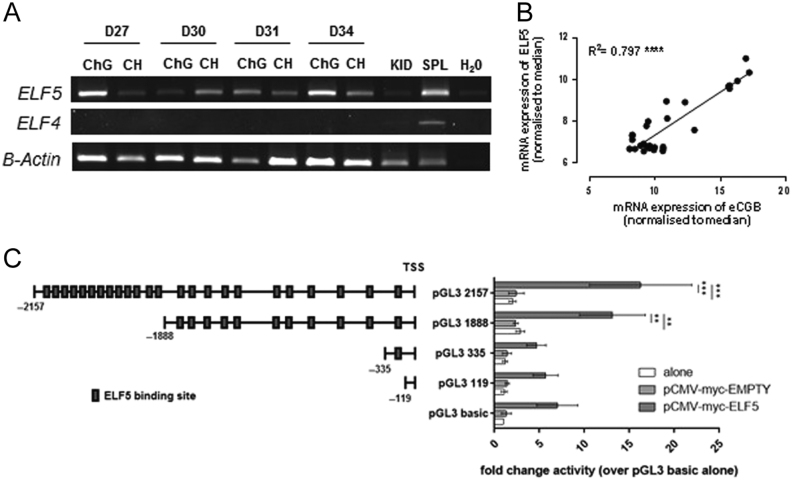
ELF5 mRNA is expressed in chorionic girdle trophoblast cells, correlates with CG/LHB mRNA expression and drives CG/LHB promoter activity. (A) ELF4 and ELF5 mRNA in equine chorionic girdle and control chorion tissues at days 27, 30, 31 and 34 of gestation as shown by RT-PCR with B-actin used as a loading control. Kidney and spleen tissues are used as control. (B) Correlation between ELF5 and CGB mRNA expression in individual day 30–34 equine chorionic girdle and chorion samples. Microarray expression data is normalised to the median in R software and displayed as fold change. (C) Truncated promoter inserts, as shown with annotated potential ELF5 binding sites, were transfected into COS7 cells alone, in the presence of 150 ng pCMV-myc-Empty or 150 ng pCMV-myc-ELF5. Numbers are relative to Translation Start Site. Promoter activity is expressed as fold change activity over pGL3-basic alone. **P < 0.01, ***P < 0.001. (n = 3, two-way ANOVA) activity is expressed as fold change activity. Over pGL3-basic alone. **P < 0.01, ***P < 0.001. (n = 3, two-way ANOVA).